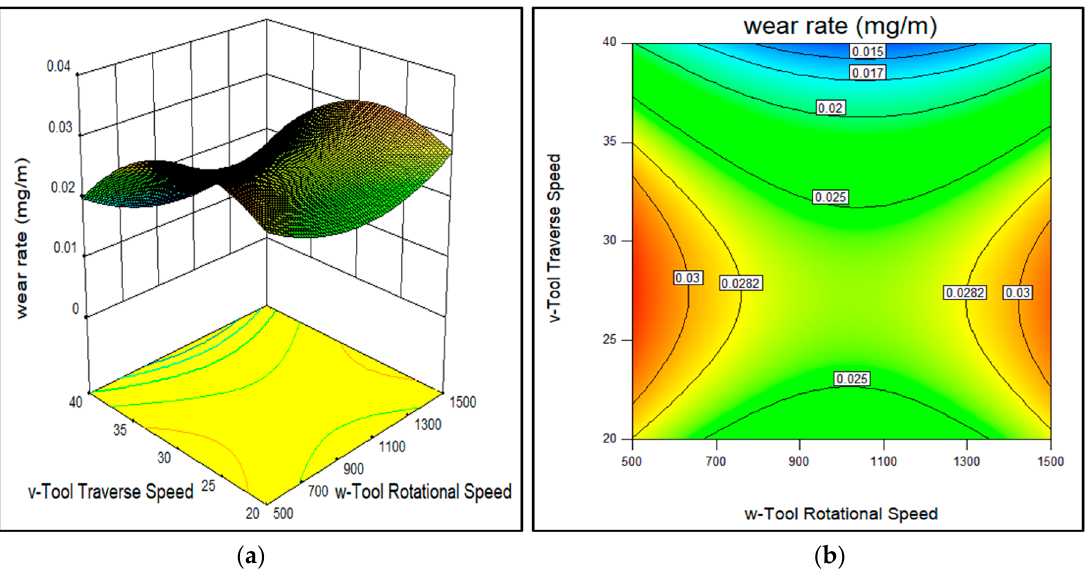
Figure 9. Effect of tool rotational speed and traverse speed on the wear rate of AA7075-SiC/fly ash Figure 9. E ff ect of tool rotational speed and traverse speed on the wear rate of AA7075-SiC / fly ash composites ( a ) 3D surface and ( b ) contour plot. composites ( a ) 3D surface and ( b ) contour